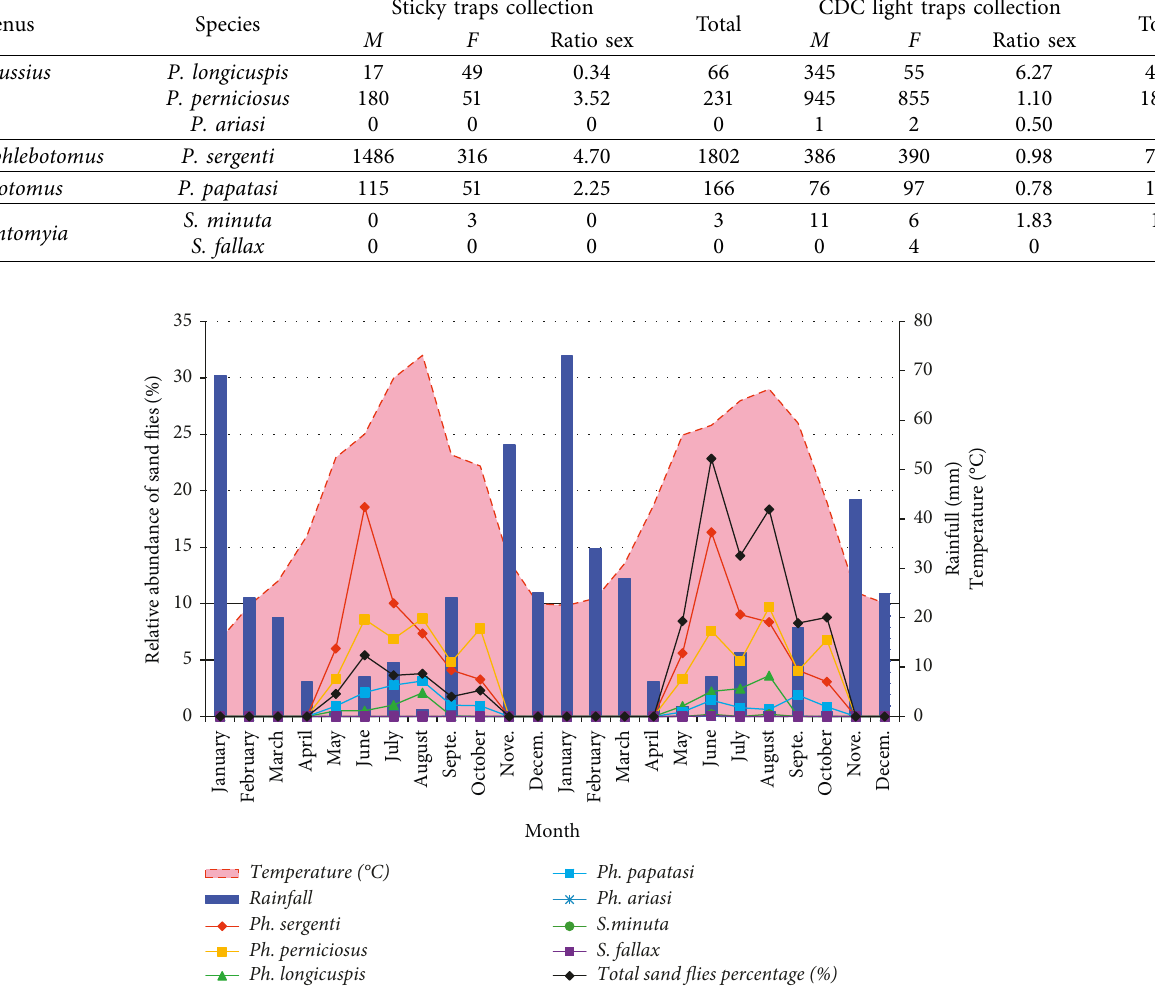
Figure 3: Seasonal dynamics of sand flies and the effect of the ecological parameters of Aichoune locality, Sefrou Province,